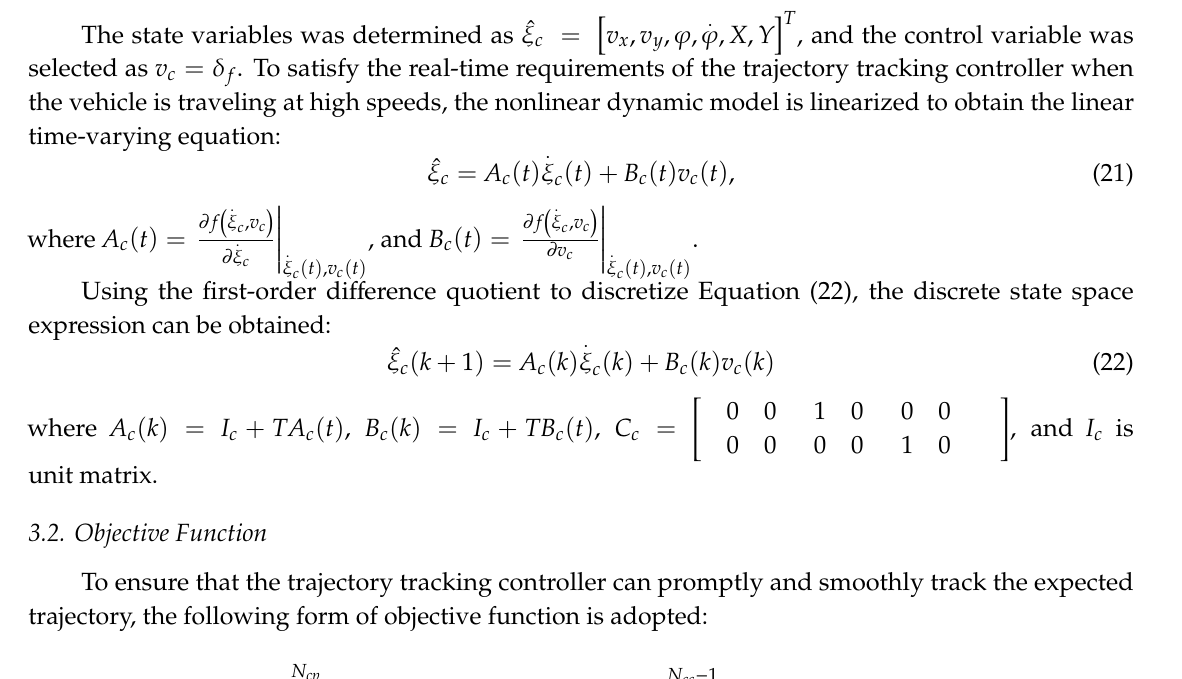
Figure 6. The vehicle monorail dynamics model.